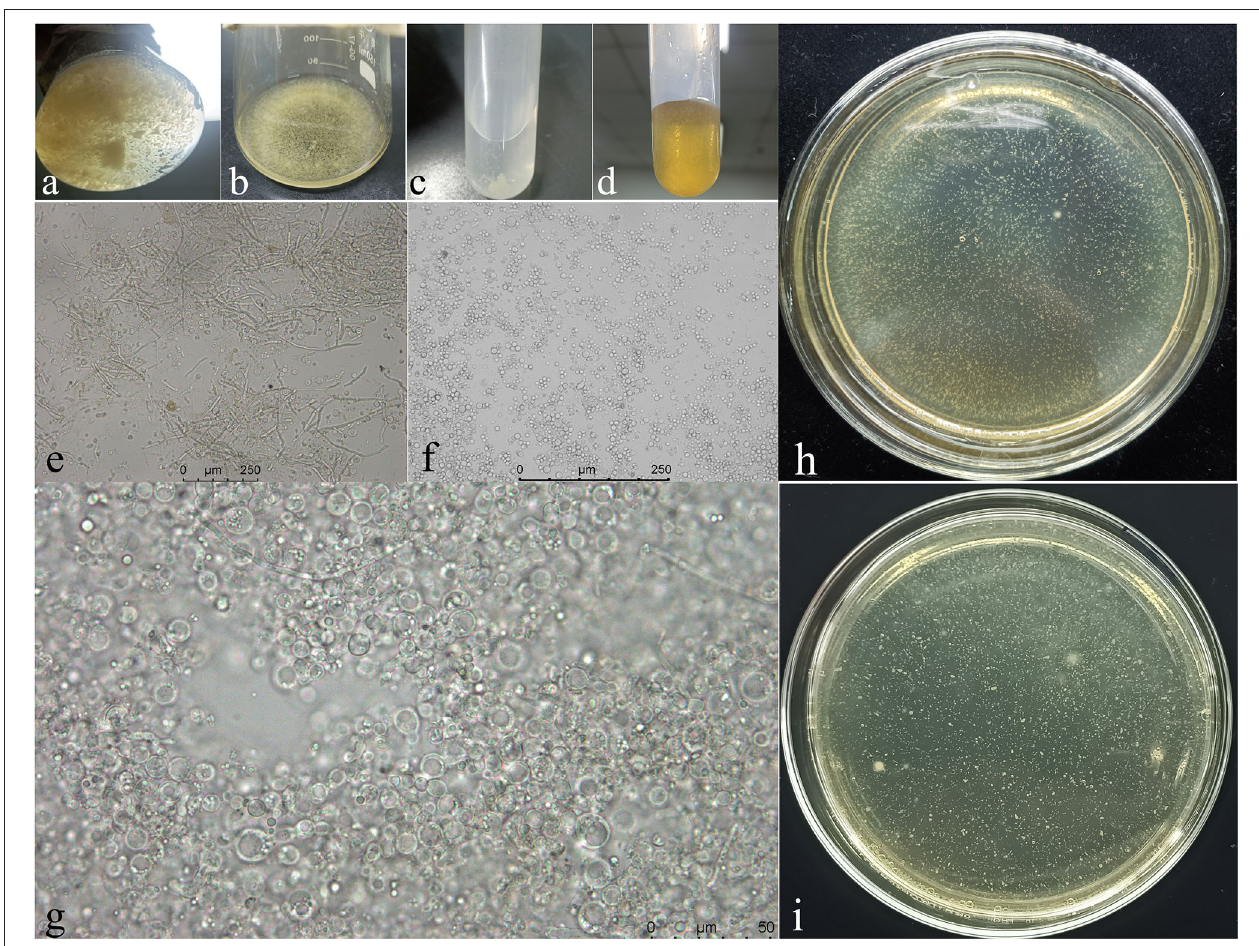
FIGURE 7 | The process of mycelium cleavage into protoplasts and the recovery of protoplasts. (a,e) , mycelium enzymolysis for 3h; (b,f) , mycelium enzymolysis for 8h; (c) , protoplast precipitation after washing and centrifugation; (d,g) , protoplast recovery after genetic transformation; (h,i) , the colonies of transformants strains cultured at 25 ◦ C for 3 days.